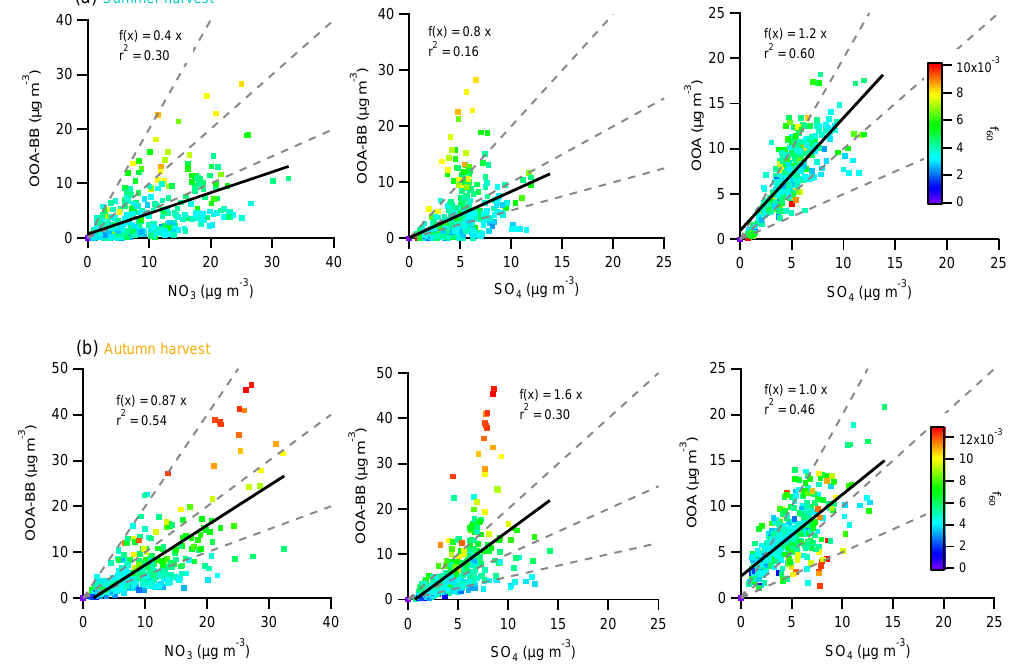
Figure 6. Comparison of two kinds of oxygenated OA (OOA-BB and OOA) and two kinds of secondary inorganic species, i.e., nitrate (NO 3 ) and sulfate (SO 4 ) , during the harvest seasons. Colored by the f 60 as a biomass-burning marker. The three dashed lines in the plot refer to 2 : 1, 1 : 1, and 1 : 2 lines,